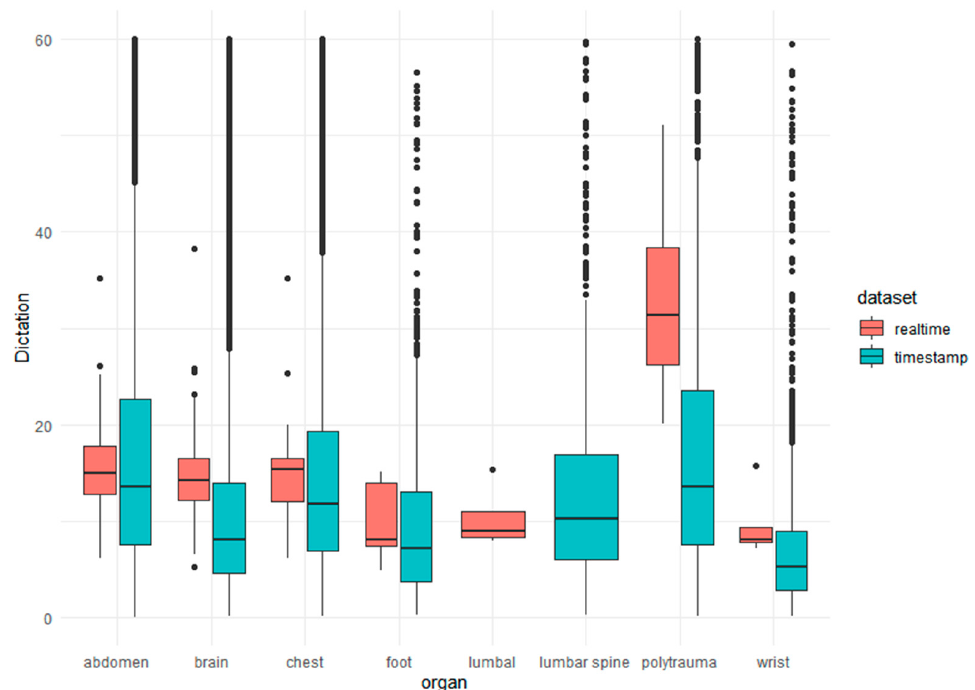
Figure 2. The box plots compare the prospective 329 real ‐ reporting times (red) with the timestamps of the 108,310 examinations (light blue) before simulation for outlier reduction. of the 108,310 examinations (light blue) before simulation for outlier